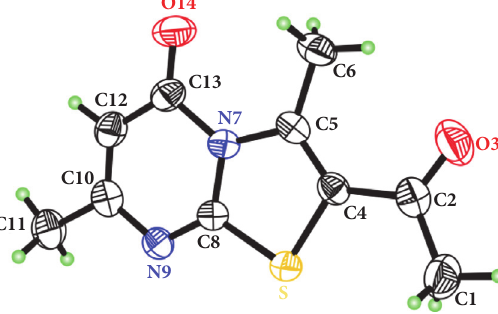
Figure 1: The structure of 2-acetyl-3,7-dimethyl-5H-thiazolo[3,2- a]pyrimidin-5-one ( 3 ).